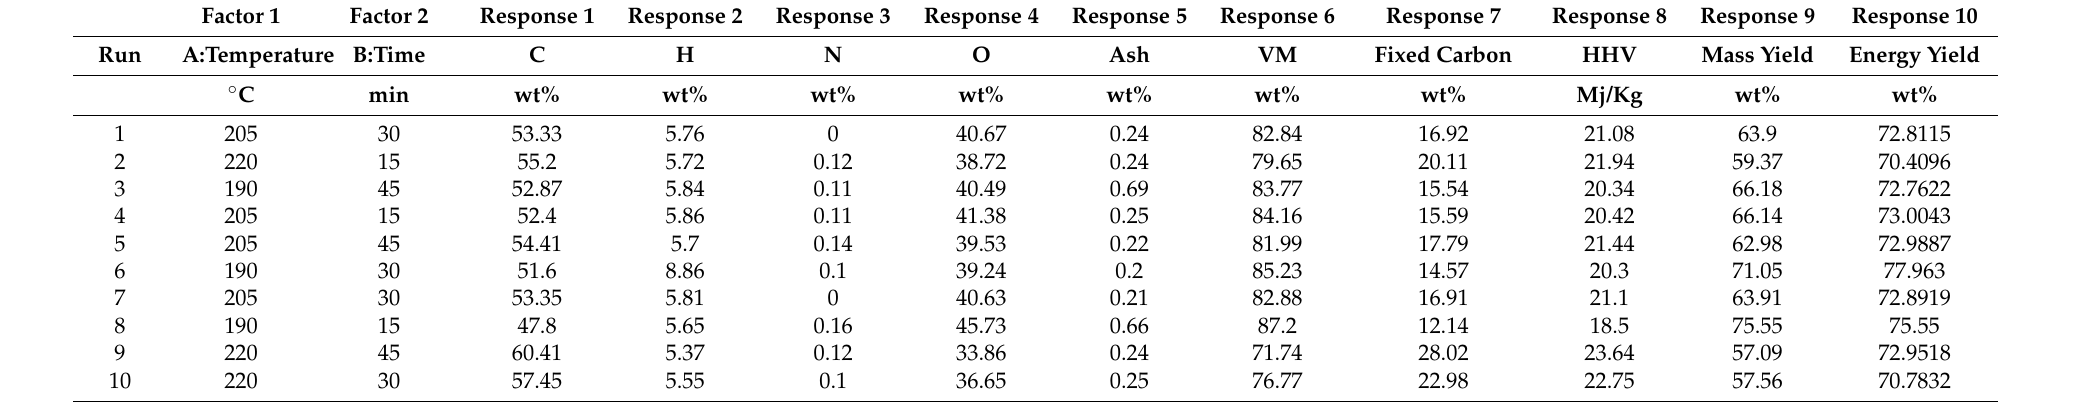
Table 4. HTC and characterization results of the designed experiments in